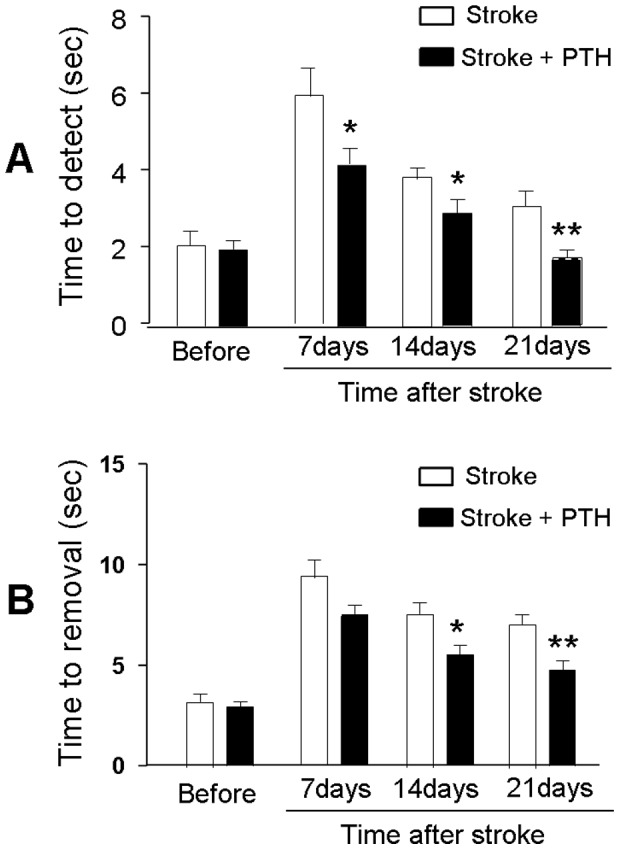
PTH treatment promoted functional recovery after stroke.The adhesive-removal test was performed to evaluate sensorimotor deficits of the mice before, and 7 to 21 days after focal cerebral ischemia. A. All mice showed impaired function in this test (increased time to detect) after stroke. Mice that received PTH, however, exhibited significantly improved sensorimotor activity (faster detection of the sticky dot) at all time points tested. B. The time to removal of the sticky dot from the affected left paw was significantly increased in all stroke animals at 7 days after stroke. PTH treatment, however, improved this sensorimotor activity so that the time to removal was significantly shorter 14 days after stroke. N = 11–20 animals, * P<0.05, ** P<0.01 vs. stroke controls at the same time point.